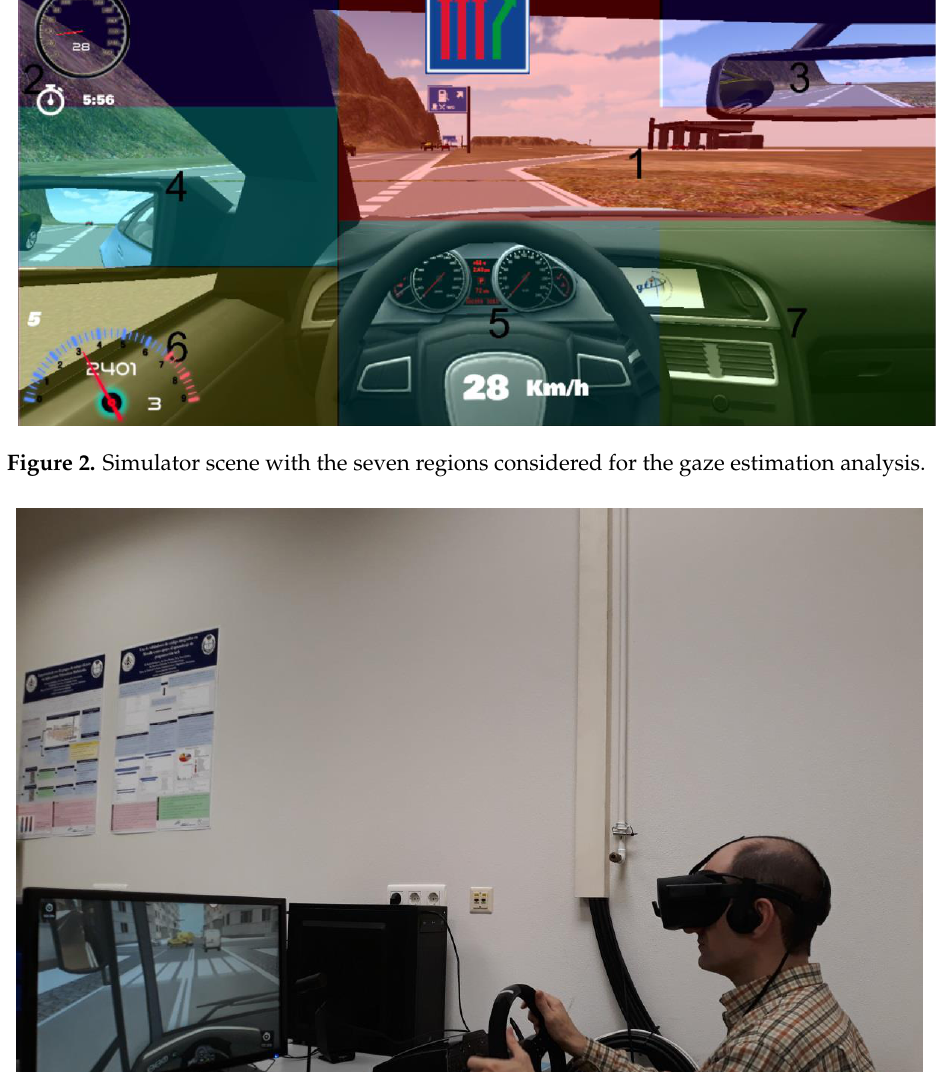
Figure 4. Images watched using Oculus Rift as the visualization display in the simulator.